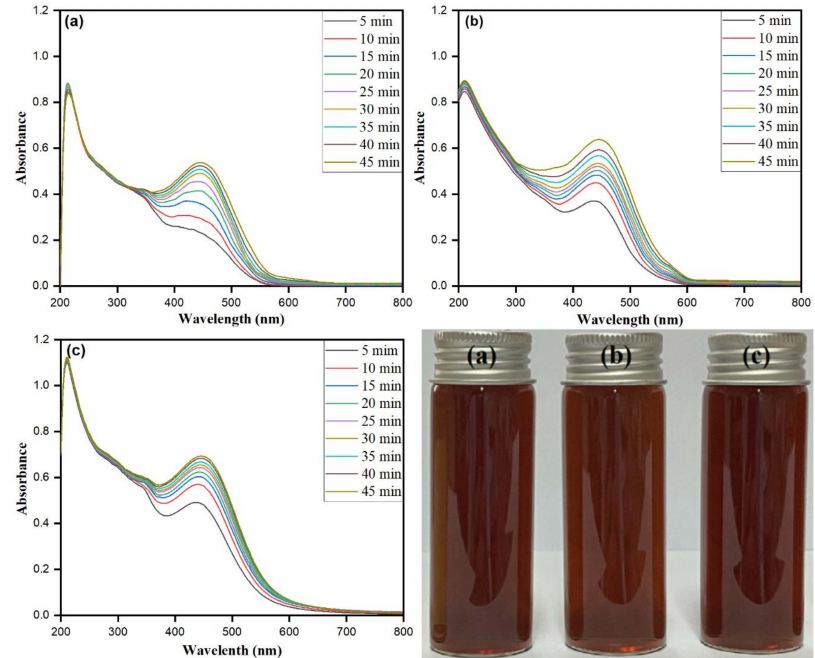
Figure 2. UV–visible absorption spectra recorded as a function of di ff erent AgNO 3 concentrations (0.5 to 2 mM) for biomolecule-assisted synthesis of AgNPs: ( a ) 0.5, ( b ) 1.0, and ( c ) 1.5 mM, at constant Matricaria chamomilla L . extract (3.0%) and sunlight exposure for 5 to 45 min. (Optical images of AgNPs at di ff erent AgNO 3 concentrations: ( a ) 0.5, ( b ) 1.0, and ( c ) 1.5 mM, and constant Matricaria chamomilla L. extract